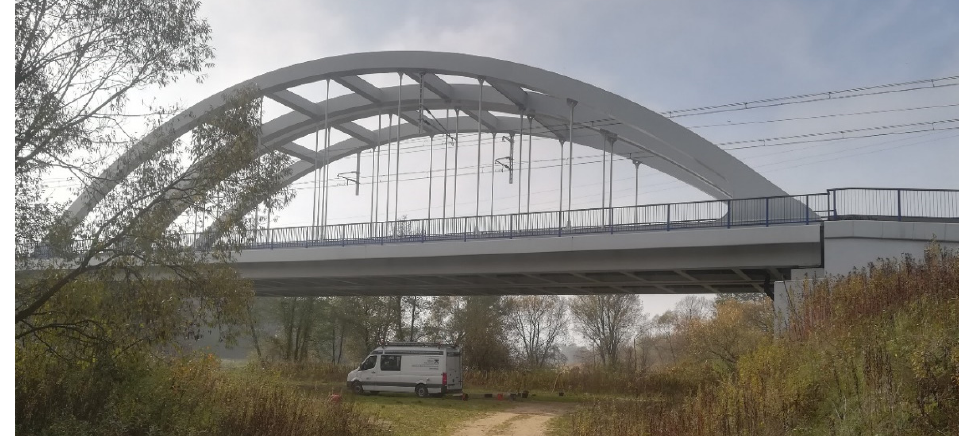
Figure 7. View of bridge No 2.